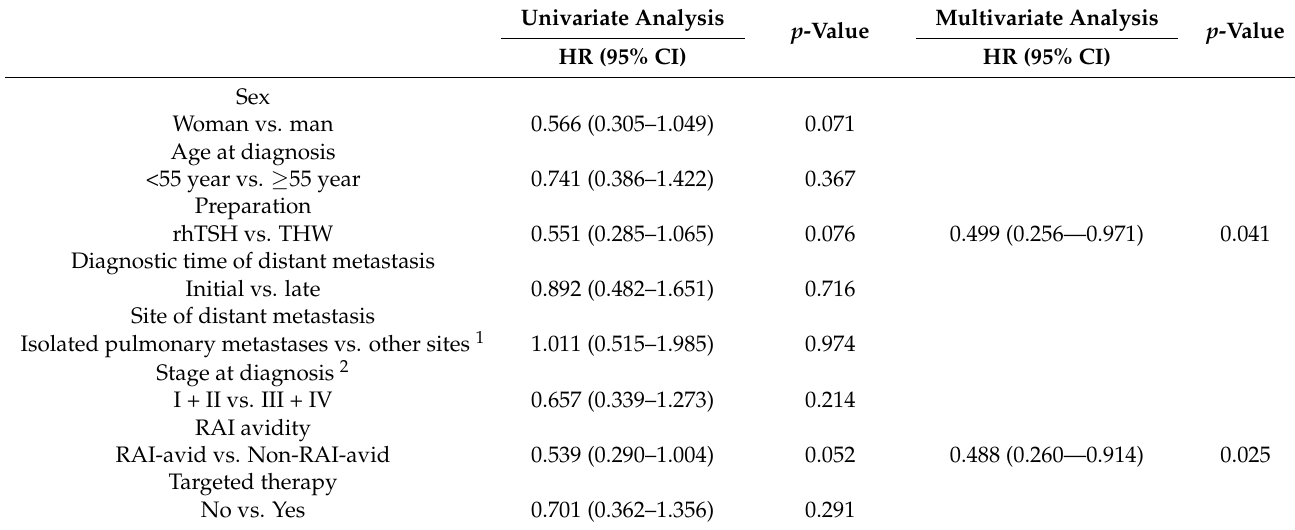
Figure 2. Kaplan–Meier plots of progression-free survival (PFS) in patients stratified according to RAI avidity and preparation method for RAI treatment ( p = 0.025). The highest 5- and 10-year PFS rates were observed in patients with RAI-avid metastases who were prepared for RAI with rhTSH. Table 2. Univariate and multivariate analyses of risk factors for progression-free survival.